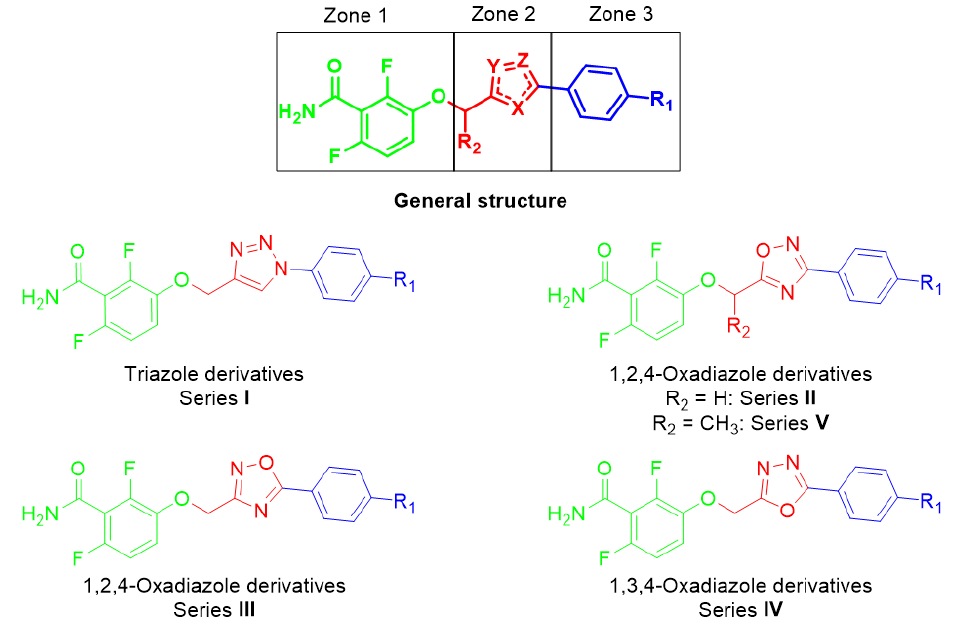
Figure 2. General structure of the compounds in this study.